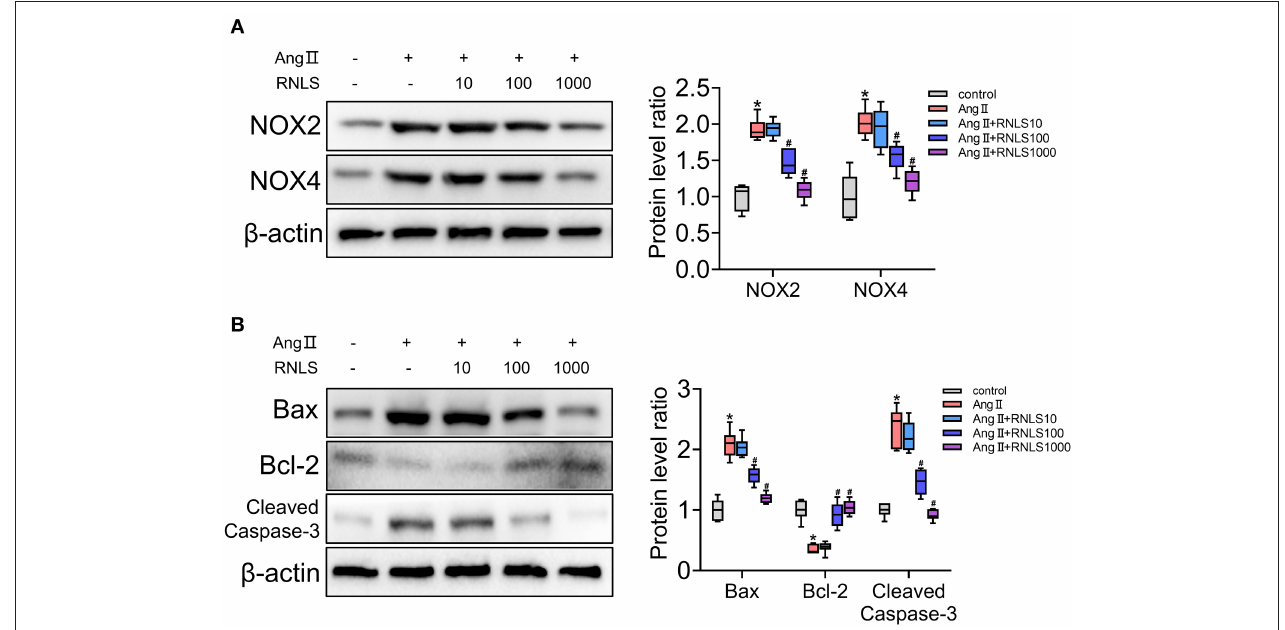
FIGURE 4 | Effect of RNLS on angiotensin II (Ang II)-induced changes in HK-2 cells. (A) NOX2, NOX4 (B) Bax, Bcl-2, and cleaved-caspase-3 protein expression in HK-2 cells were detected using western blot. HK-2 cells were incubated with various concentrations of RNLS (10, 100, or 1000ng/mL) in the absence or presence of Ang II (1 µ M). Data are presented as Box-whisker Plot. * P < 0.05 (Control vs. Ang II), # P < 0.05 (Ang II + RNLS vs. Ang